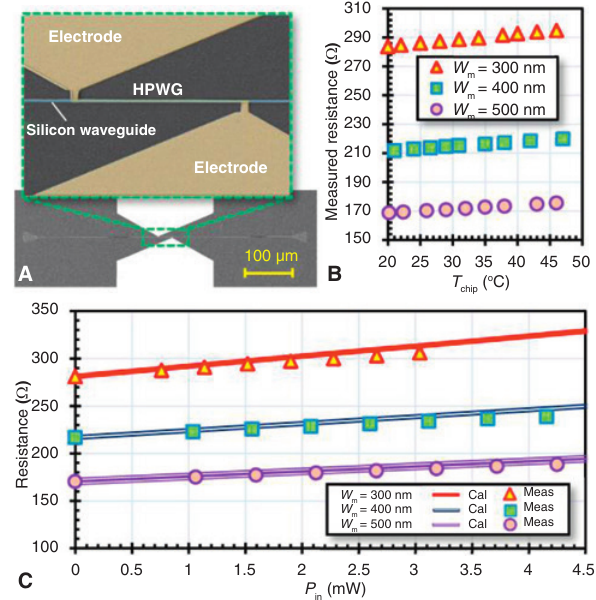
Figure 2: A photothermal power monitor based on a single HPWG. (A) Scanning electron microscopy (SEM) pictures of the silicon HPWG with electrodes to measure the resistance of metal strip. Inset: details